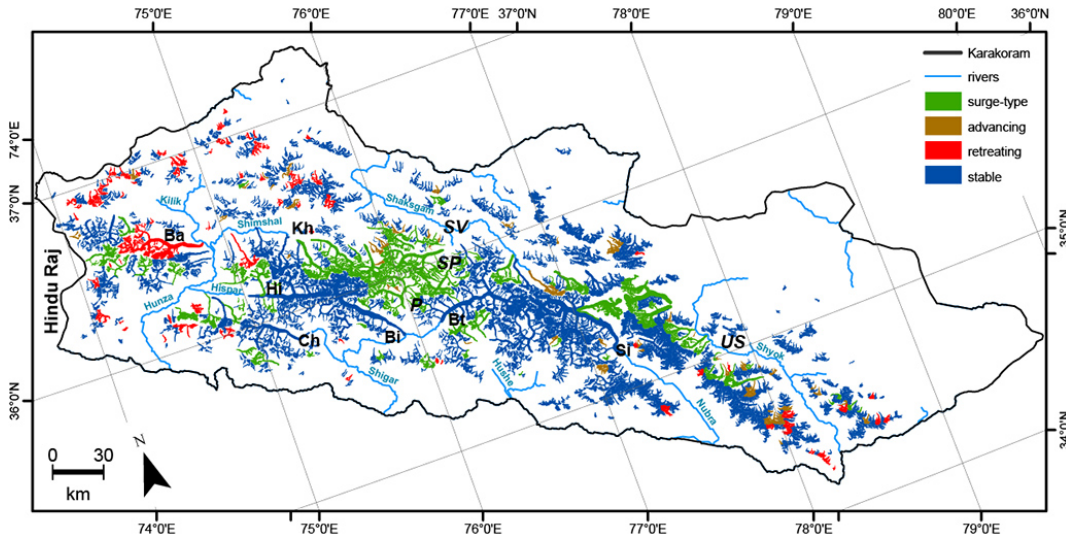
Figure 3. Spatial distribution of glaciers classified as surge-type, advancing, retreating, or stable across the Karakoram during the observation period 1976–2012. Abbreviations: Ba – Batura Glacier, Bi – Biafo Glacier, Bt – Baltoro Glacier, Ch – Chogo Lungma Glacier, Hi – Hispar Glacier, Kh – Khurdopin Glacier, Si – Siachen Glacier, P – Panmah Basin, SP – Sarpo Laggo Basin, SV – Shaksgam Valley, and US – upper Shyok Valley.